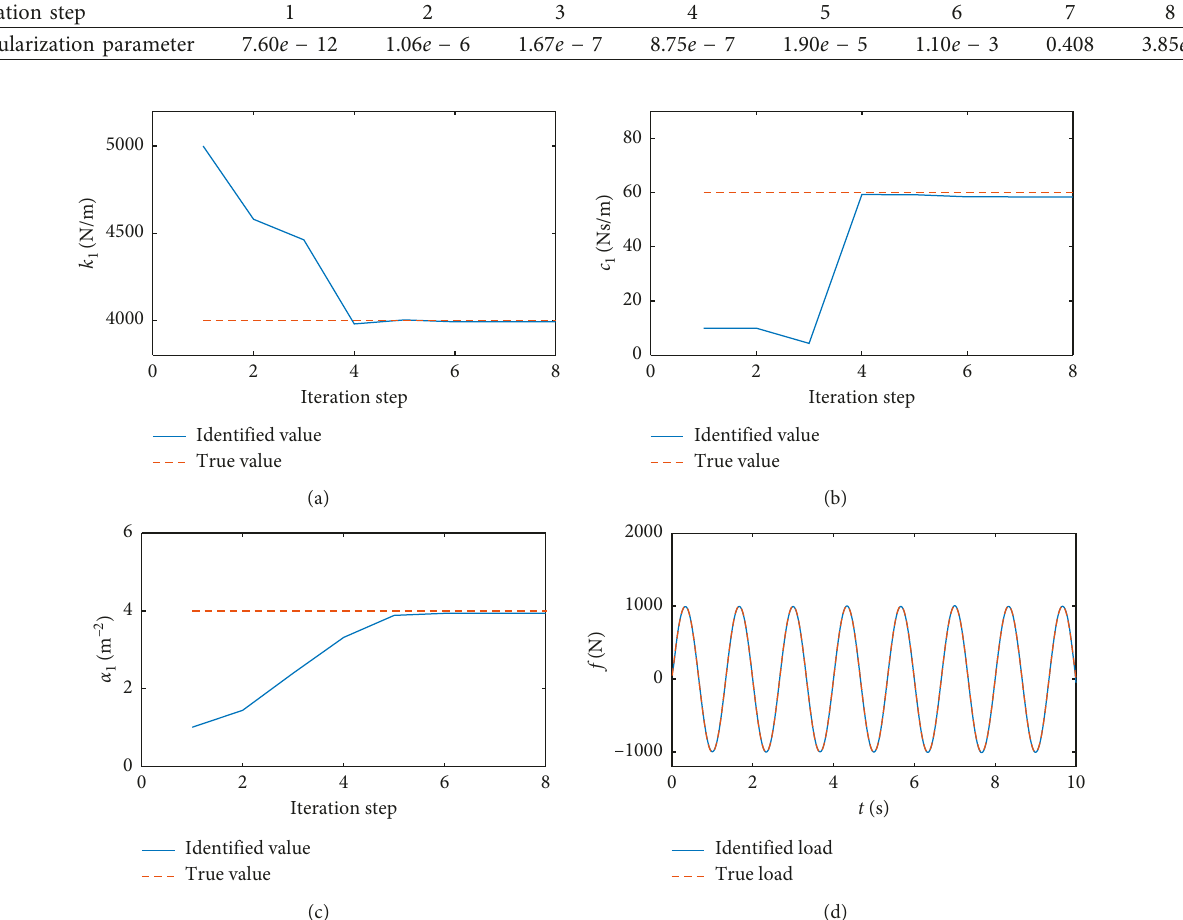
Figure 2: The convergence processes of (a) k